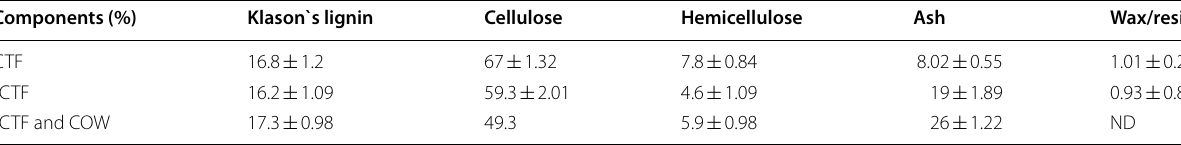
Table 3 Main chemical compositions of CTF, tCTF and tCTF and COW